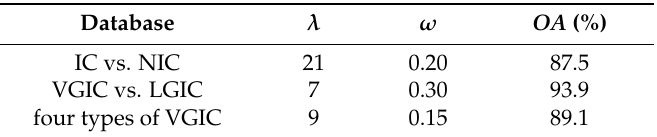
Table 1. Optimal parameters for the three datasets.